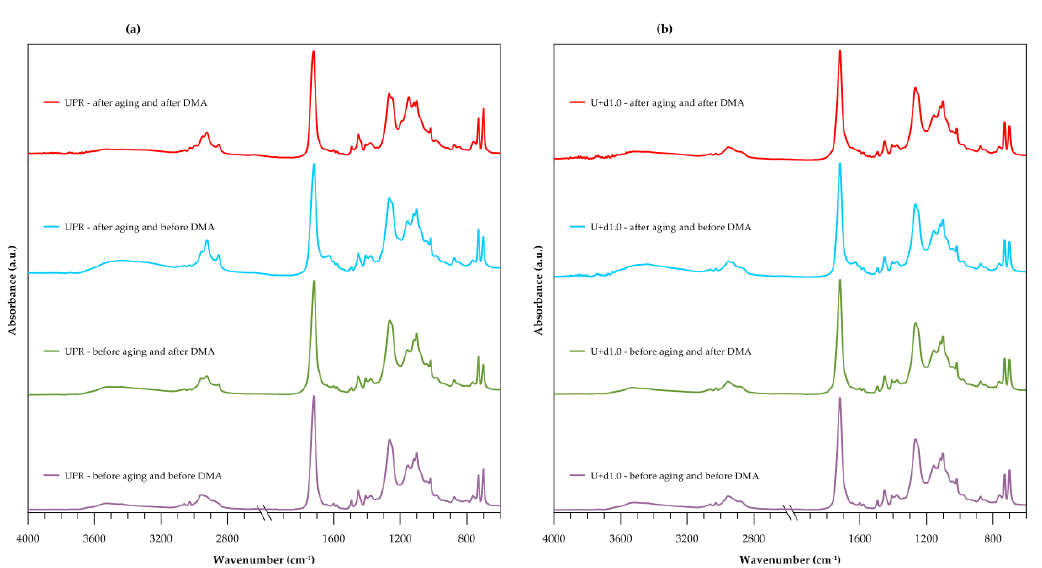
Figure 1. FT-IR / ATR spectra of the composites before and after the aging test and dynamic mechanical analyzer (DMA). ( a ) Pure resin and ( b ) resin with